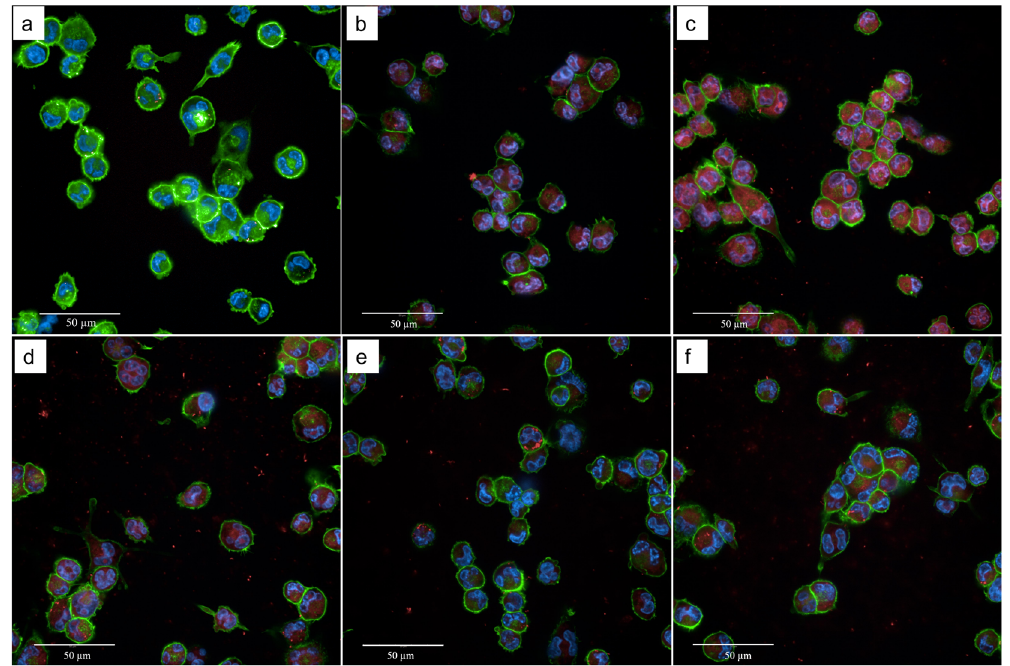
Figure 2. Effect of TB on the phagocytosis in THP-1-derived macrophages. THP-1-derived macrophages were incubated for 30 min without ( a ) or with different concentrations of TB (( b ) = 10 8 ; ( c ) = 5 × 10 7 ; ( d )= 10 7 , ( e ) = 5 × 10 6 , ( f ) = 10 6 ) and the effect on phagocytosis was evaluated. Representative images (one of three replicates) are shown (Blue: Hoechst, Green: actin, Red: TB) ( a – f ). Scale bar 50 µm.